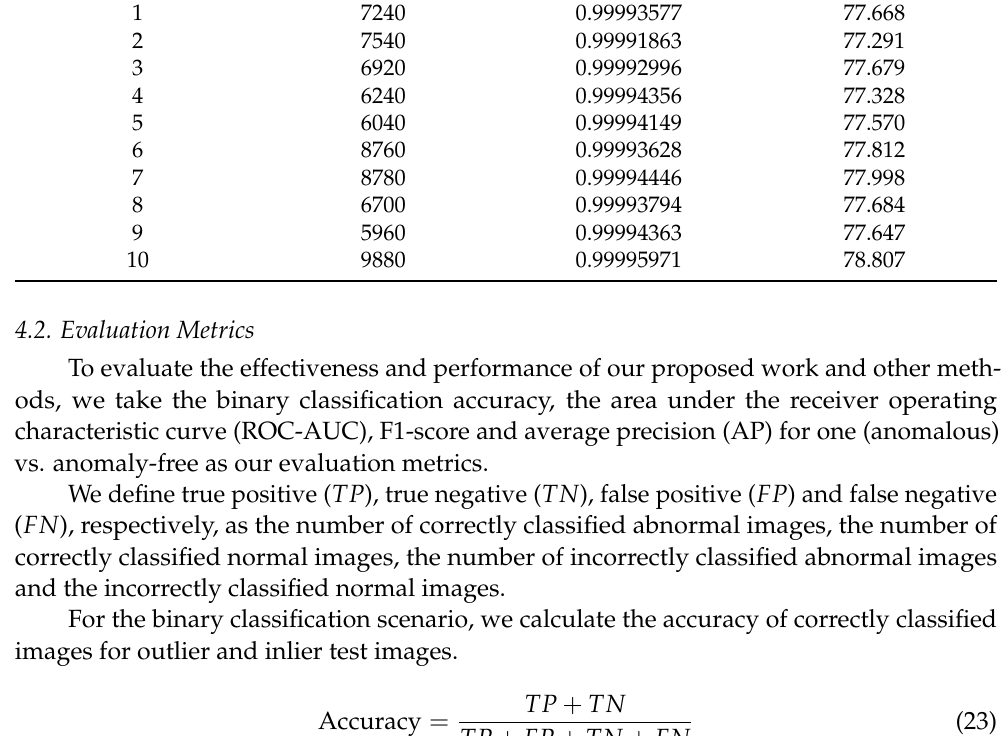
Figure 4. The curve of the VAG model training for every 20 epochs over 10,000 epochs. ( a ) Mean_SSIM; ( b ) Mean_PSNR. Table 2. The top10 value of Mean_SSIM and Mean_PSNR of the VAG model training.